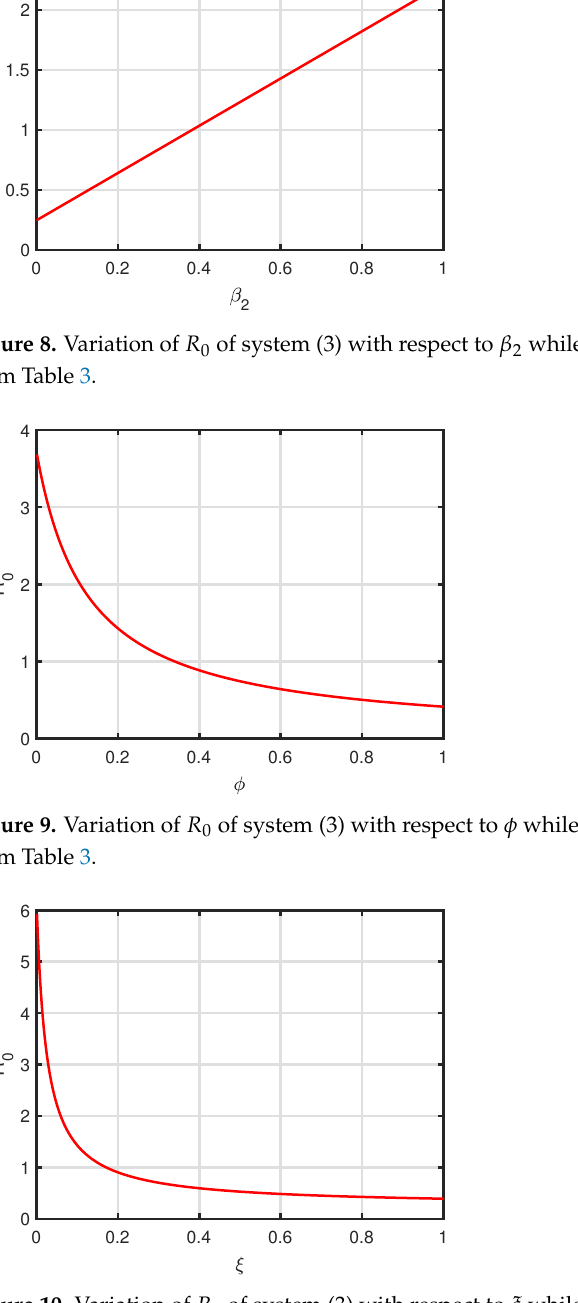
Figure 10. Variation of R 0 of system (3) with respect to ξ while values of other parameters are taken from Table